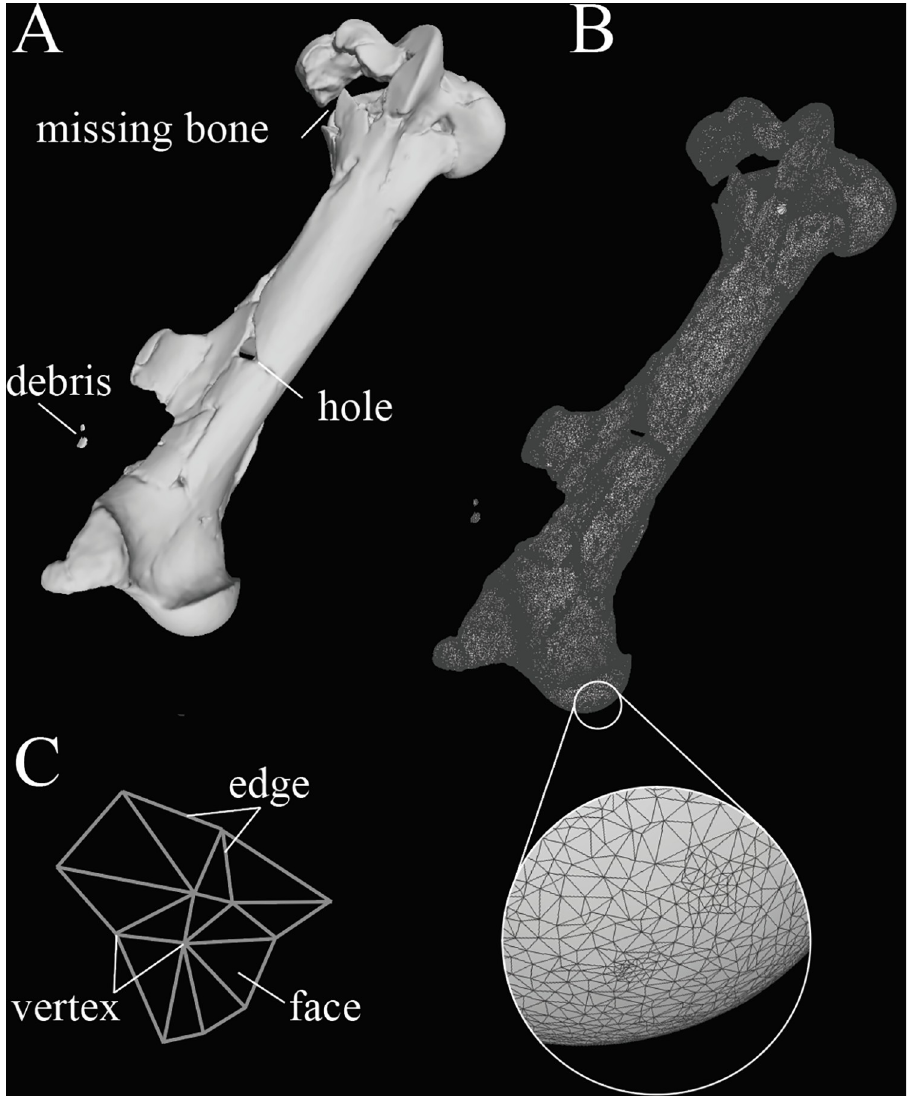
Fig 1. (A) 3D reconstruction of a left femur from Equus sp. (UF 234402) downloaded from morphosource.org and visualized using Meshlab [20]. Specimen demonstrates several preservational issues commonly encountered while working with 3D imaging data (labeled). (B) View of the mesh components that comprise the 3D reconstruction, which includes (C) edges, vertices and